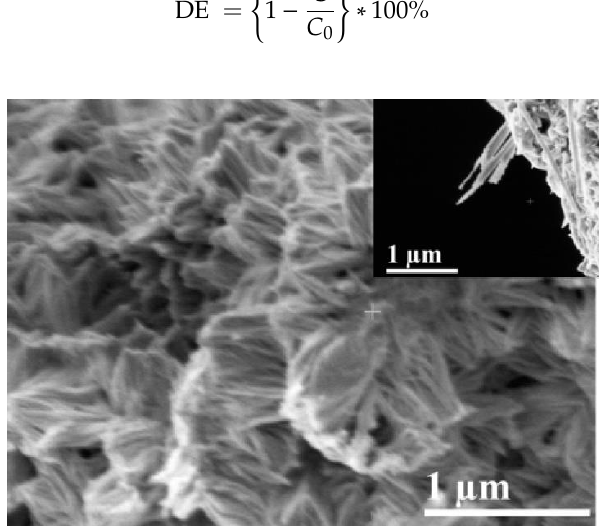
Figure 6. Cross-sectional image of Nb 2 O 5 NAs.